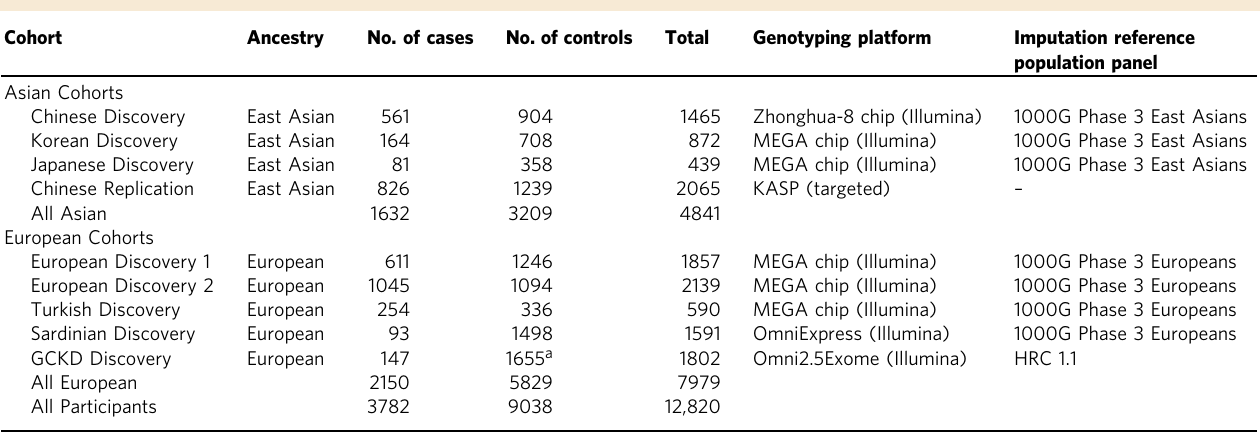
Table 1 Baseline characteristics of participants in the discovery and replication cohorts.